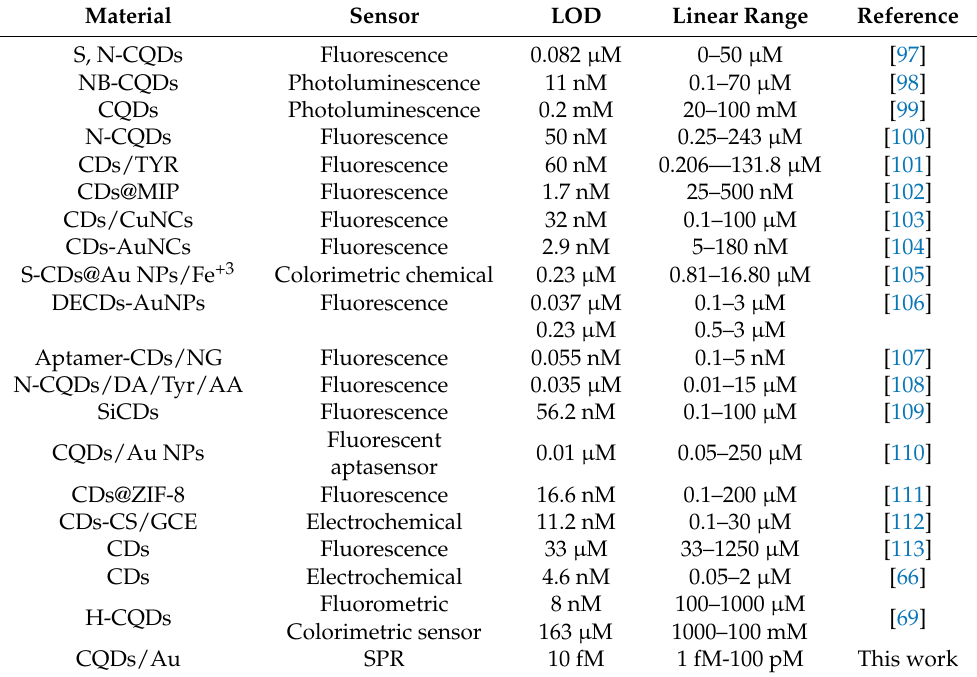
Table 2. Comparison of the proposed SPR sensor with other DA sensors using CQDs in terms of limit of detection and response range.